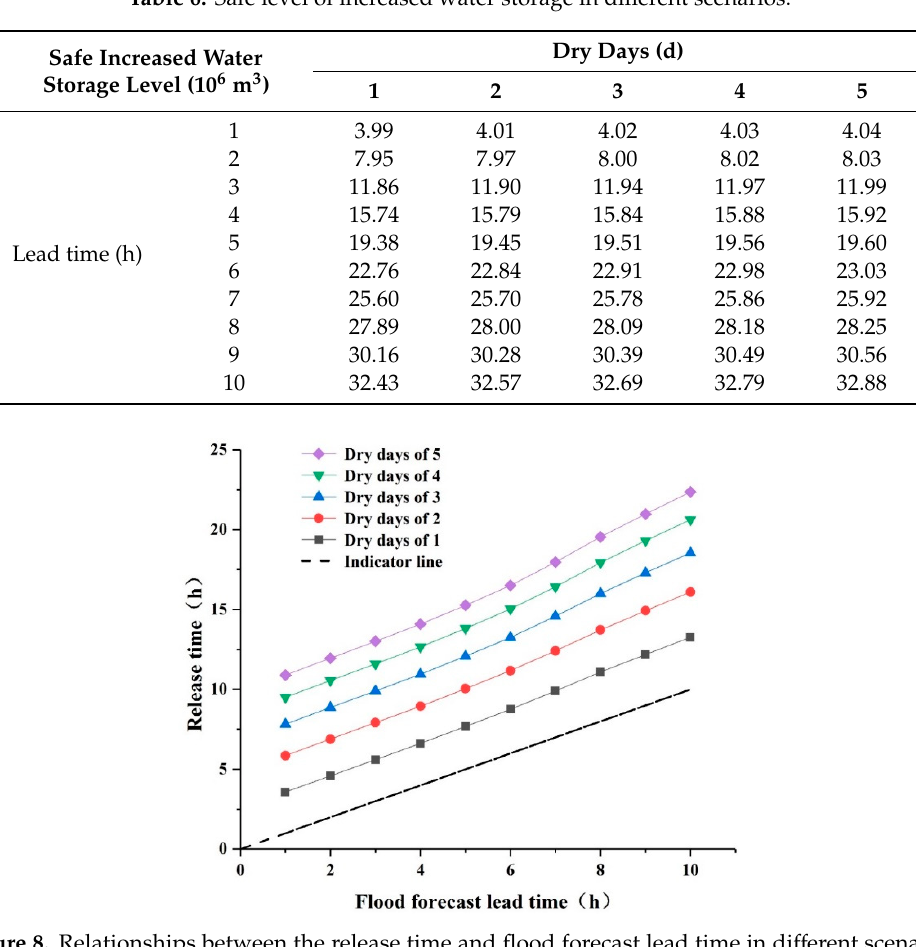
Figure 8. Relationships between the release time and flood forecast lead time in different scenarios. Note: the top left of the indicator line shows that floodwater stored over the FLWL cannot be released completely within the lead time.